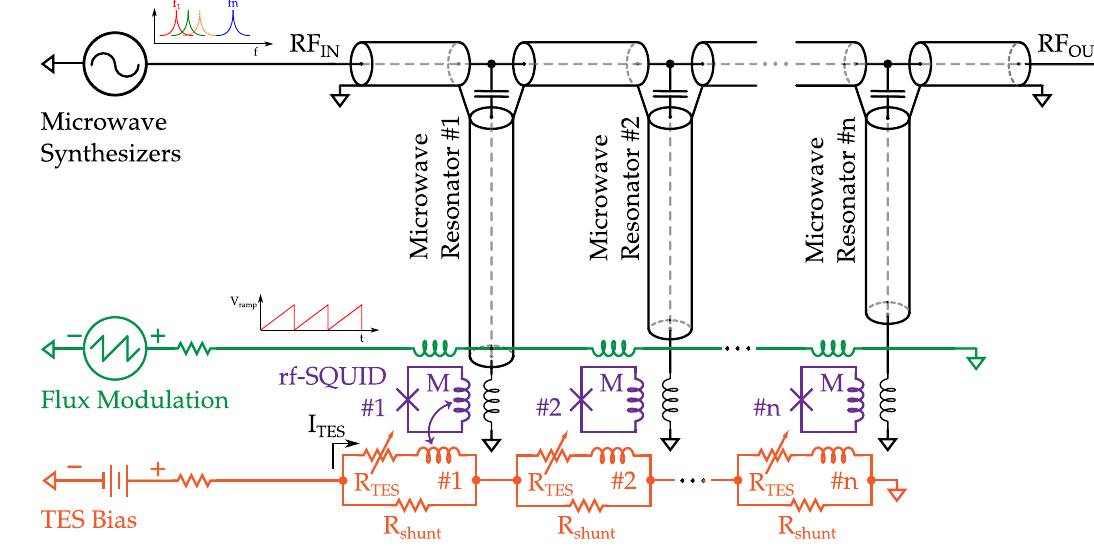
Fig. 1 Schematics of the readout used for HOLMES. The orange por- tionofthedrawingisthebiascircuitwiththesensors,theshuntresistors andthecouplinginductorstotherf-SQUIDs(purple).These,inturn,are